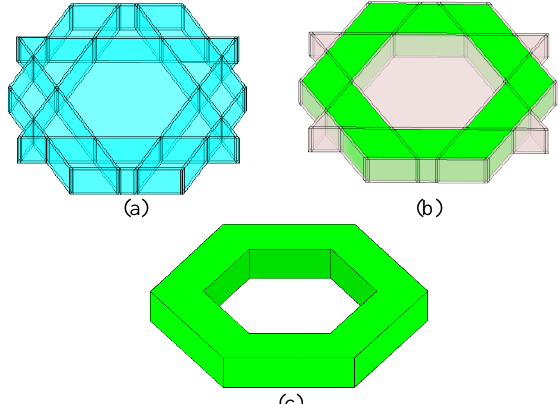
Fig. 5. Results for the synthetic dataset: (a) 3D cell decomposition, (b) the classification of cells into navigable spaces (green) and non-navigable spaces (light pink), (c) the final